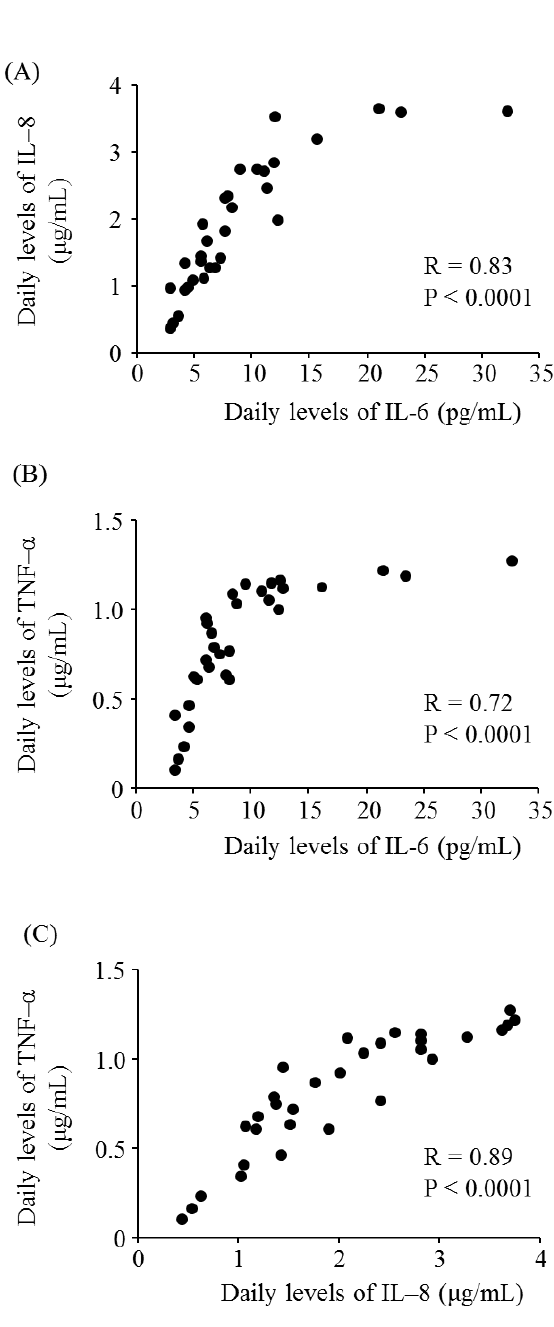
Figure 4. Associations among the daily levels of pro-inflammatory cytokines produced by THP1 human monocyte cells in response to stimulation with particulate matter. ( A ) Correlation of daily interleukin (IL)-6 and IL-8 levels; ( B ) Correlation of daily IL-6 and tumor necrosis factor (TNF)- α levels; and ( C ) Correlation of daily IL-8 and TNF-α levels.